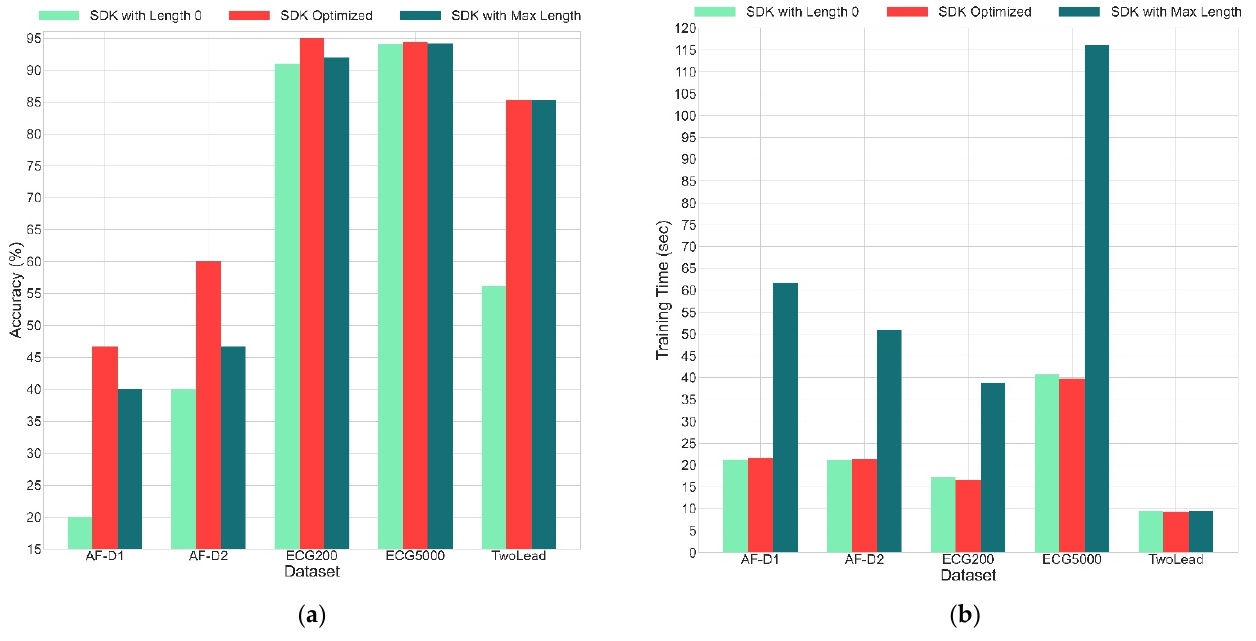
Figure 12. Performance compared when applying optimized shallow domain knowledge and other length of shallow domain knowledge for each dataset: ( a ) accuracy when applying optimized shallow domain knowledge compared with length with 0 and maximum pattern length; ( b ) training time for the same situation. Table 8. Performance evaluation of SDK-Injection among various lengths of shallow domain knowledge.